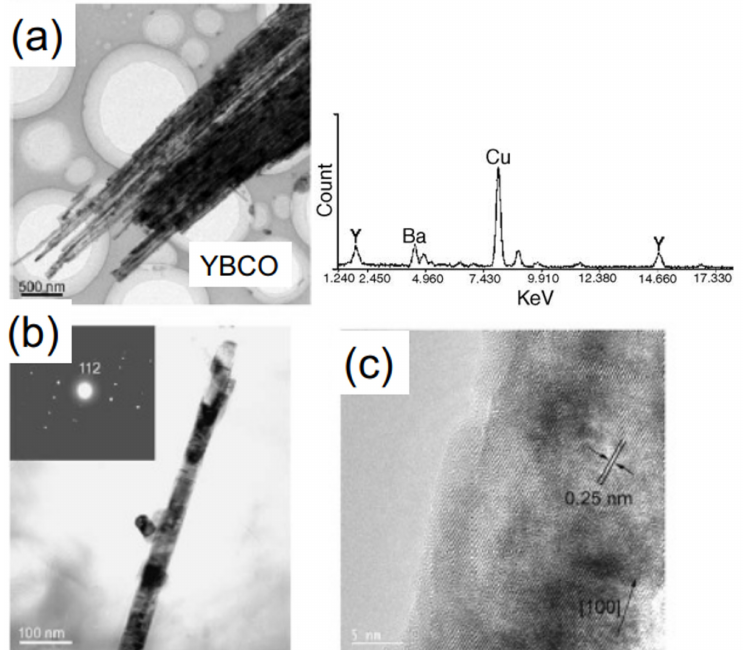
Figure 5. YBCO nanowires prepared by AAO-templating, released from the AAO template ( a ). The EDX spectrum on the right side did not reveal Al; ( b ) gives a TEM image of a representative YBCO nanowire with a diameter of ∼ 45 nm and a length up to the thickness of the AAO template. The inset shows the corresponding electron diffraction pattern, demonstrating the single-crystalline nature of the YBCO nanowires; ( c ) shows the lattice structure of an individual YBCO nanowire by HRTEM. Reprinted with permission from Ref. [39]. Copyright 2004